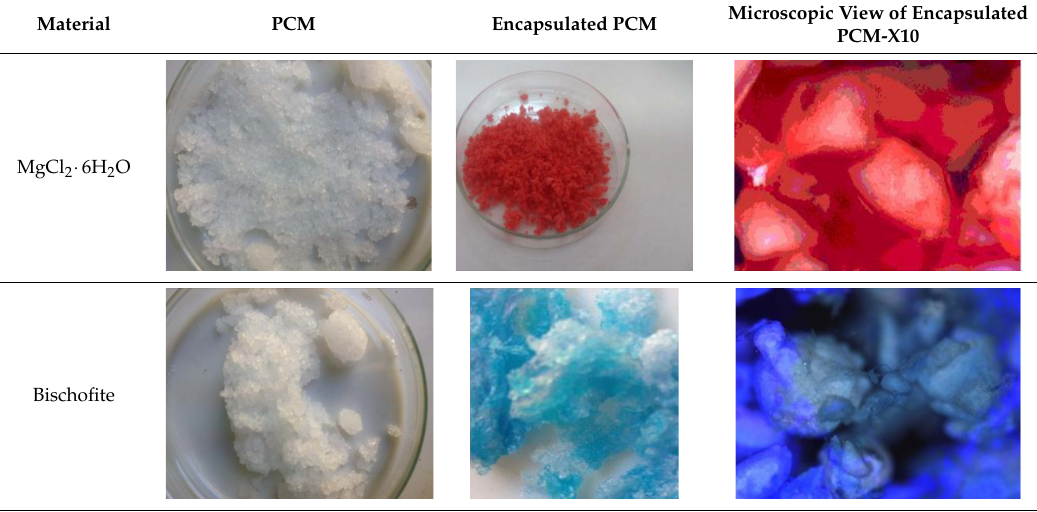
Table 7. View of the materials before encapsulation ( left ), after encapsulation ( middle ) and after encapsulation with a microscope ( right ).